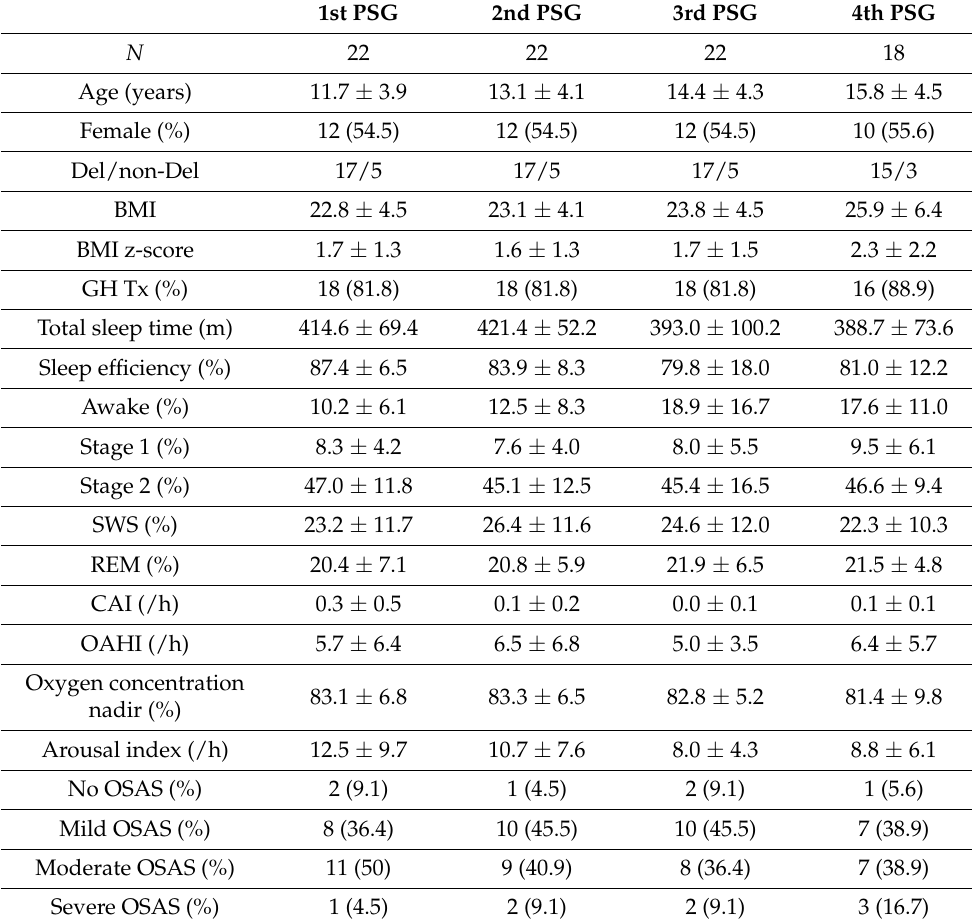
Table 1. Demographic data and summary of the polysomnographic variables during longitudinal follow-up of patients with PWS for 4 years.